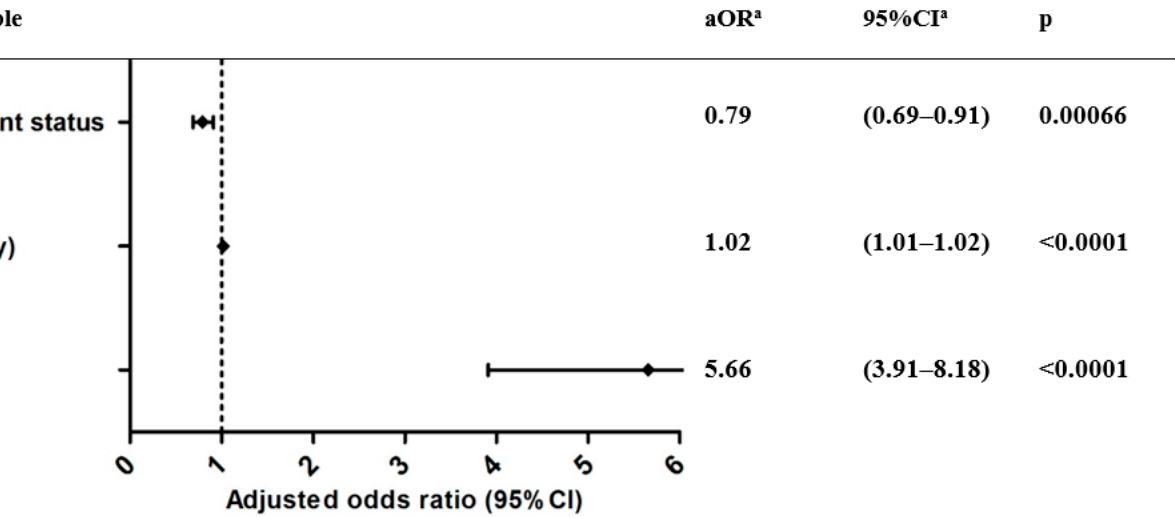
Figure 3. Identification of factors contributing to suboptimal (I + II) hepatitis HCU. a : OR = odds ratio; CI = confidence interval; aOR = adjusted odds ratio; adjusted for sex, age, migrant status, cirrhosis, diabetes, COPD, malignancy, HIV. Optimal = diagnosed and treated; suboptimal I = diagnosed and followed-up; suboptimal II = only diagnosed.